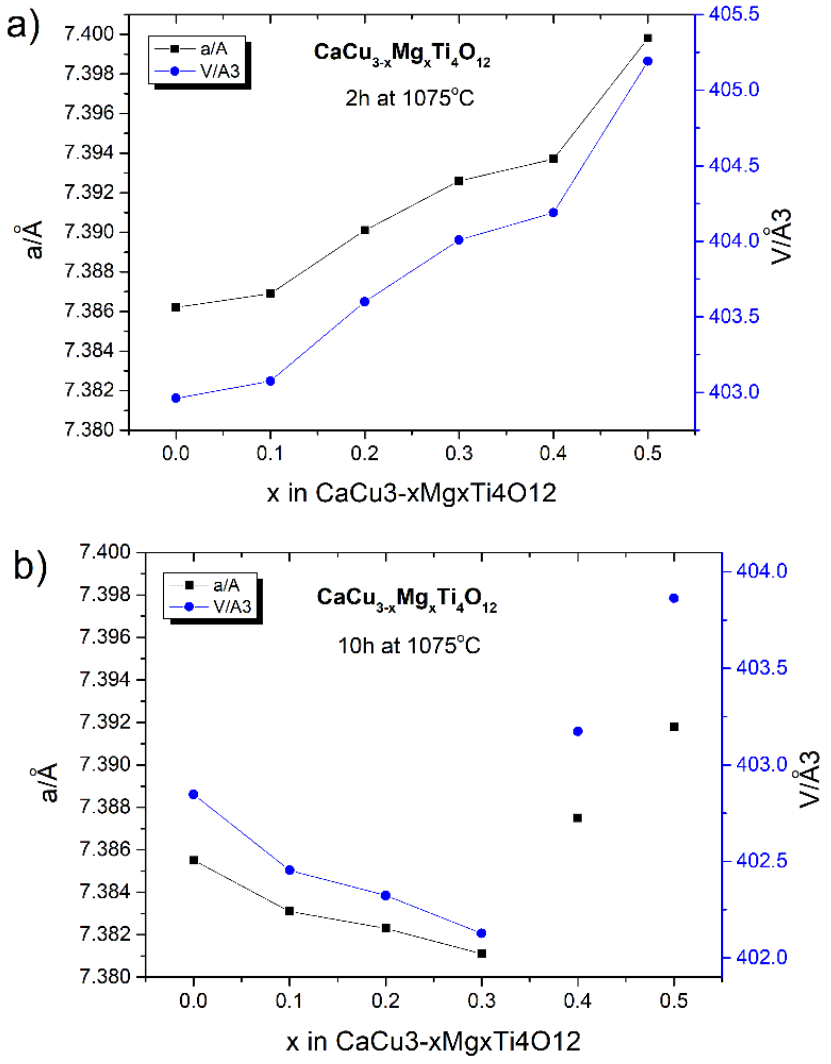
Figure 6 . Lattice parameters of the mechanochemically-prepared CaCu 3 Ti 4 O 12 and CaCu 3−x Mg x Ti 4 O 12 (0.1 ≤ x ≤ 0.5) samples, as determined from the XRD data, subjected to subse- quent heat treatment for different times: ( a ) 2 h at 1075 °C; ( b ) 10 h at 1075 °C